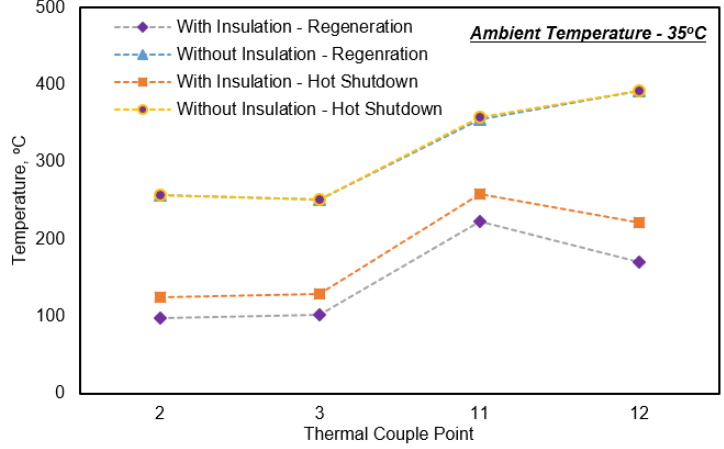
Figure 8. Max temperature at aftertreatment inlet and outlet